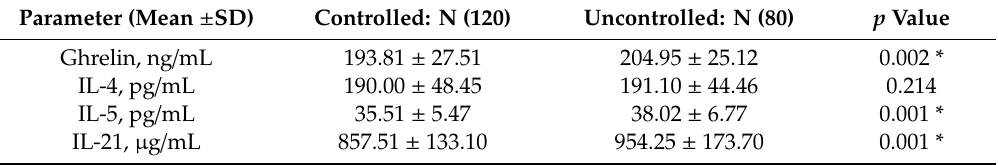
Table 3. Ghrelin and interleukin levels among the study sample by the control of bronchial asthma. Parameter (Mean ± SD) Controlled: N (120) Uncontrolled: N